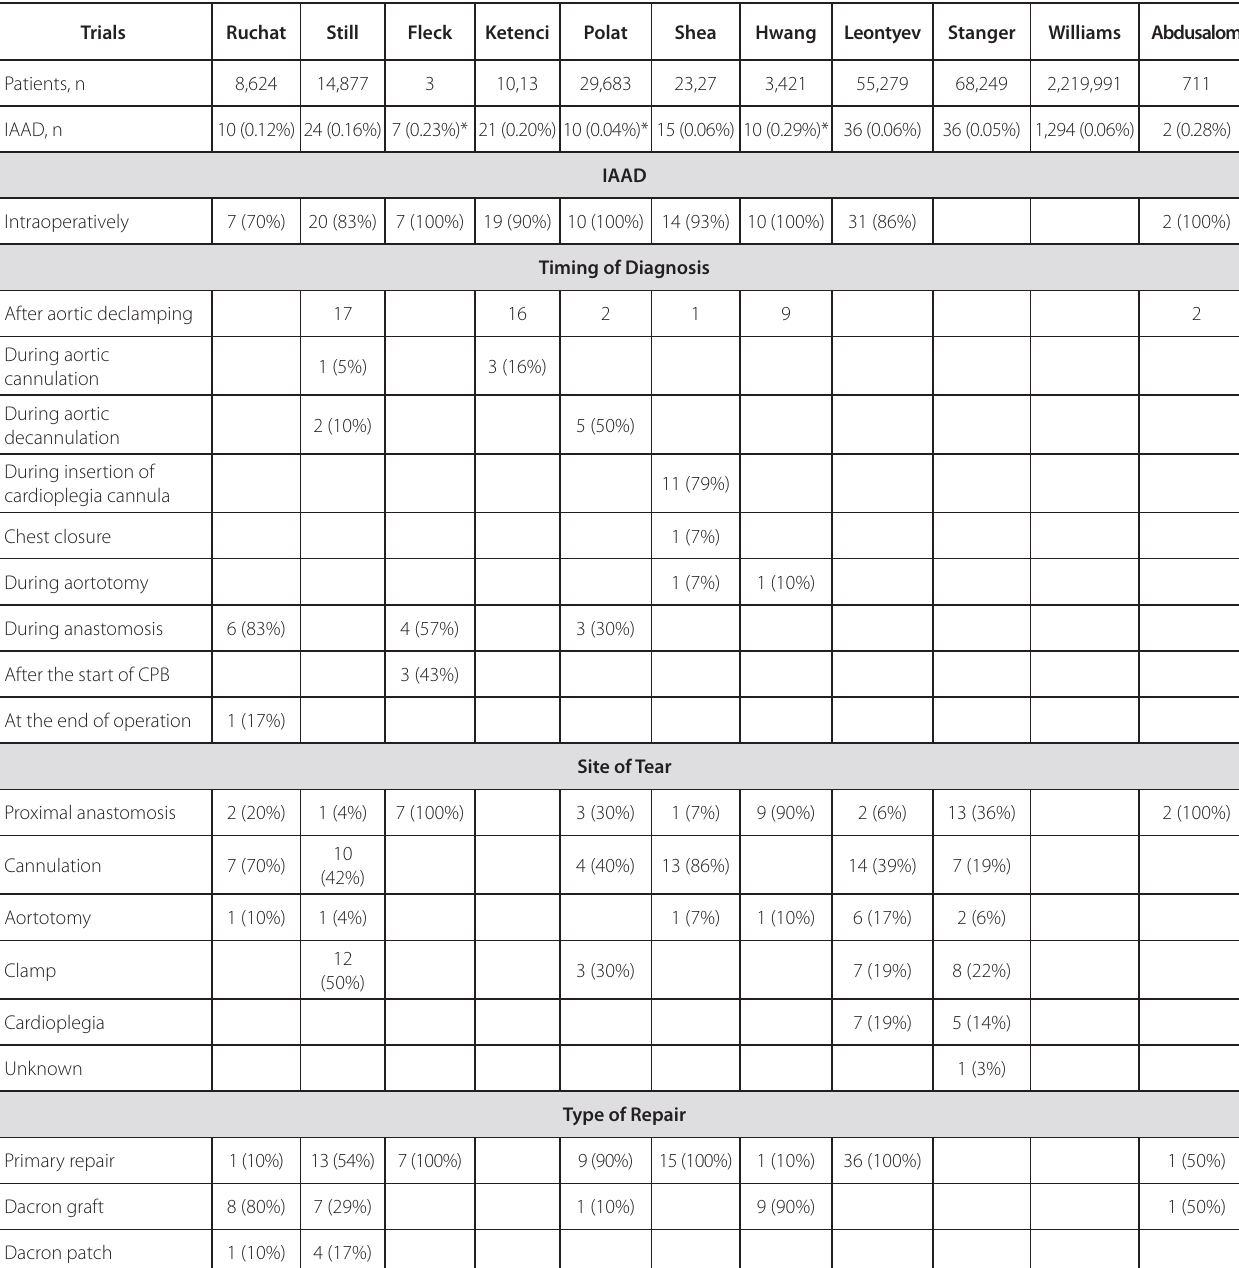
Table 2 . Surgical data of patients with iatrogenic acute aortic dissection (IAAD) during cardiac surgery.